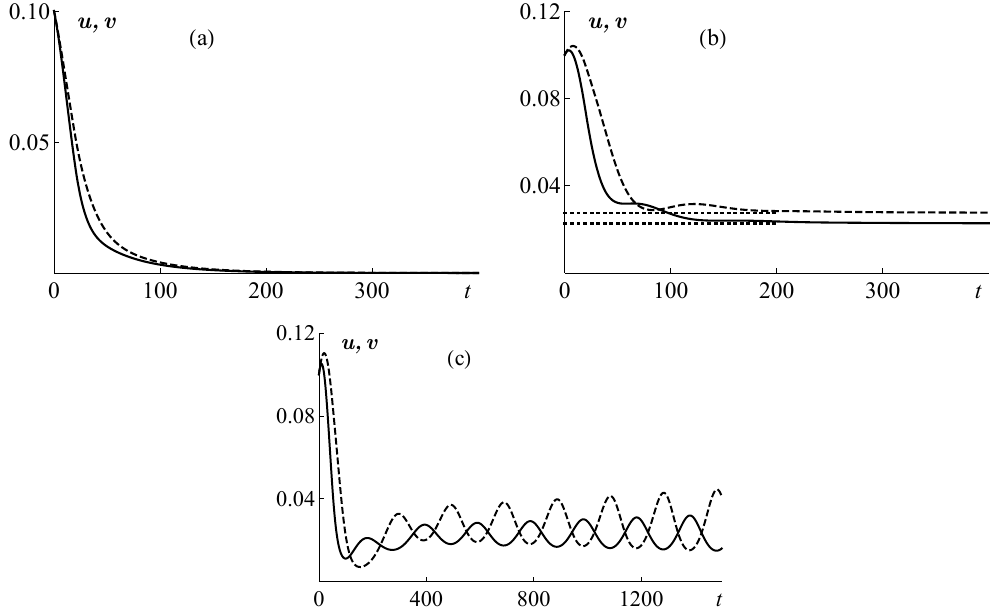
Figure 1. Numerical solutions u = u ( t ) (solid line) and v = v ( t ) (dashed line) of problems (6)–(8) with x = π /2 for d 1 = 0.4, d 2 = 0.7 in the cases: ( a ) b = 0.98, τ = 20, ( b ) b = 1.01, τ = 20, ( c ) b = 1.01, τ = 30; dotted lines correspond to the stationary solution for x = π